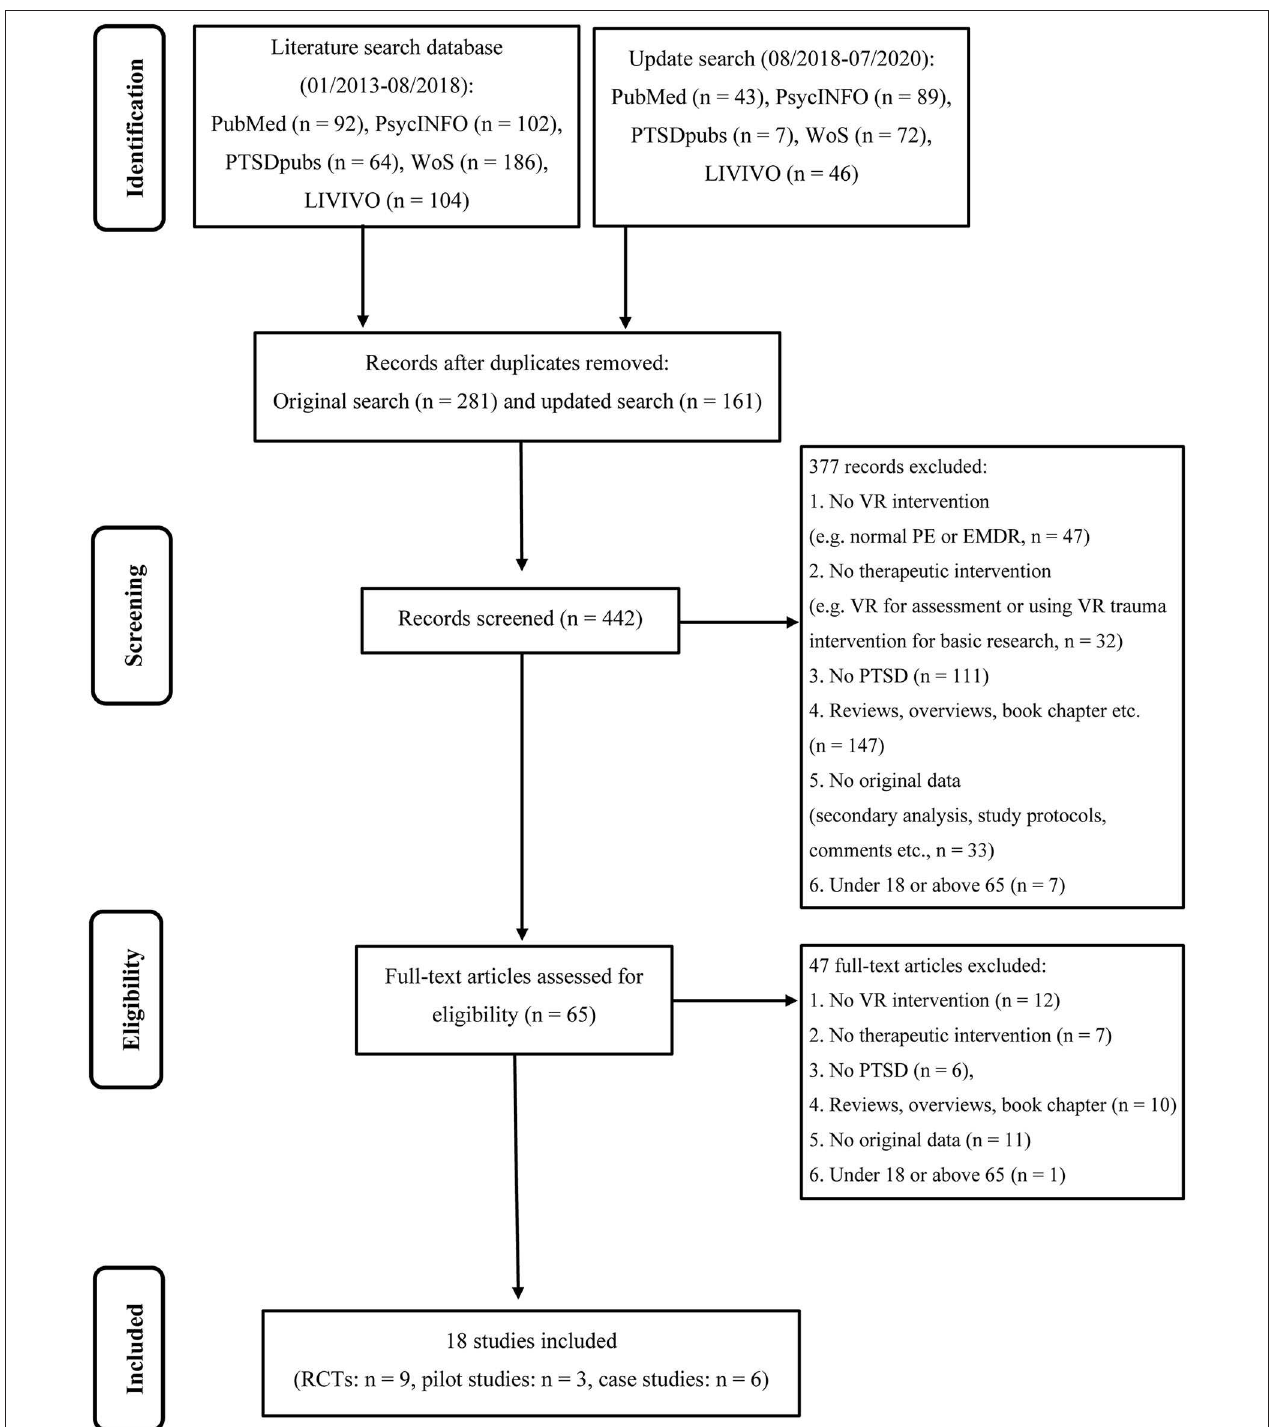
FIGURE 1 | PRISMA flowchart of screening, exclusion, and inclusion criteria. (33.3%) (Vermetten et al., 2013; Arens, 2014; Kengne et al., 2018; Menelas et al., 2018; Nijdam and Vermetten, 2018; Van Gelderen et al., 2018) were case studies examined a total of 10 patients and three (16.6%) (Beidel et al., 2017b; Jetly et al., 2017; Loucks et al.,